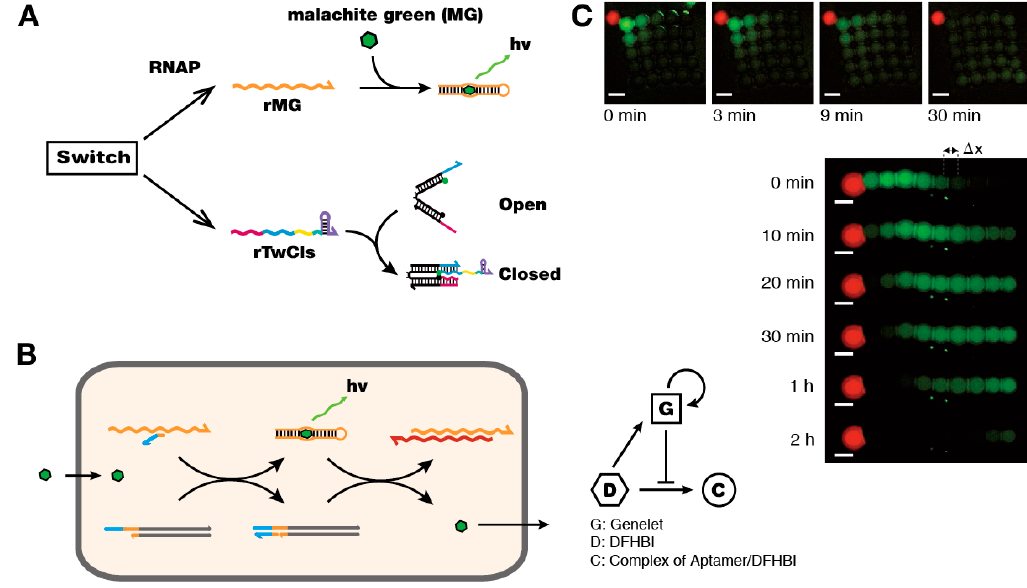
Figure 4. Extension of genelet circuits. ( A ) Driving downstream processes with genelet circuits. The output signal from genelet circuits can be functional RNA aptamers or can be used to drive DNA nanodevices such as DNA tweezers. ( B ) Signal propagation using encapsulated genelet circuits. Each droplet contains a genelet switch and aptamer-activator complex. Signal molecule (DFHBI) binds the aptamer and releases the DNA activator for the genelet switch. The activated genelet in turn produces kleptamer that binds the aptamer, releases DFHBI, and attenuates fluorescence output. ( C ) The experimental fluorescence images for one- and two-dimensional signal propagation. Reproduced with permission from [15,16].